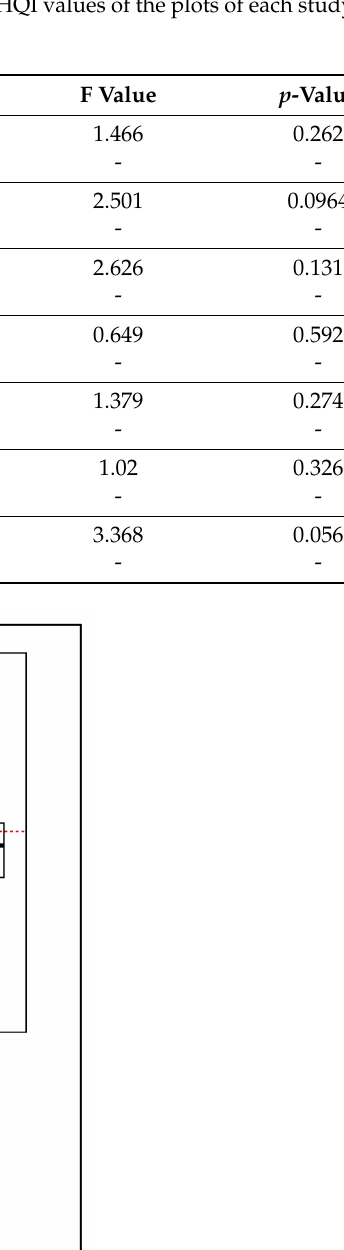
Table 5. Results of the ANOVA tests applied to the initial HQI values of the plots of each study group.